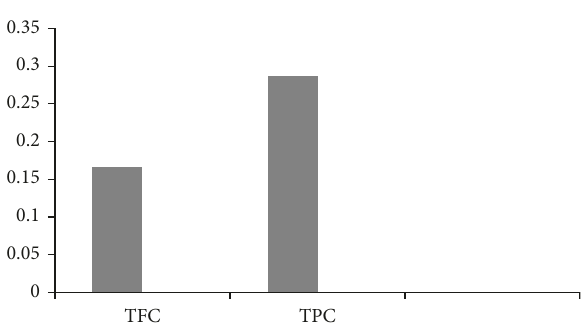
Figure 2: Total phenolic content (TPC) and total flavonoid content (TFC) of the methanolic extract of Spirulina expressed as μ gmg GAE/g DW and mg QE/g DE, respectively ( n